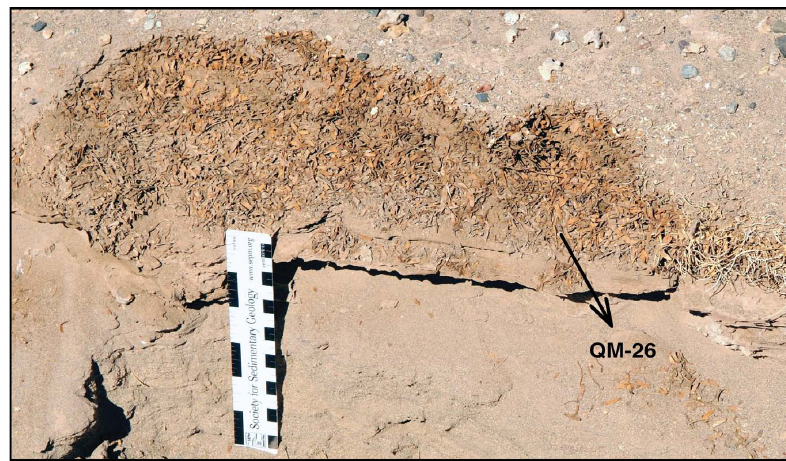
Fig. A1. Detail from an in situ leaf-litter deposit. Note the presence of abundant woody materials.